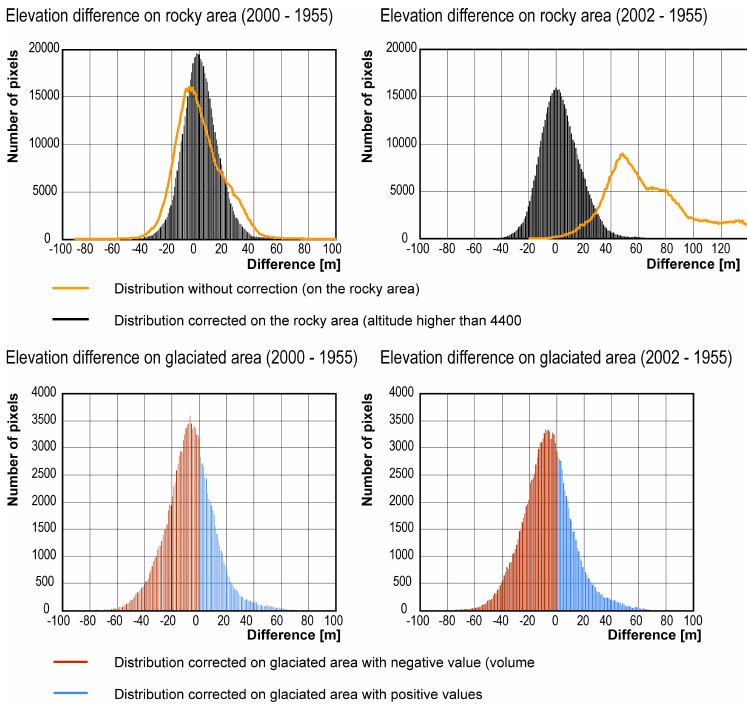
Fig. 7. Elevation differences on rock and on glaciated areas.